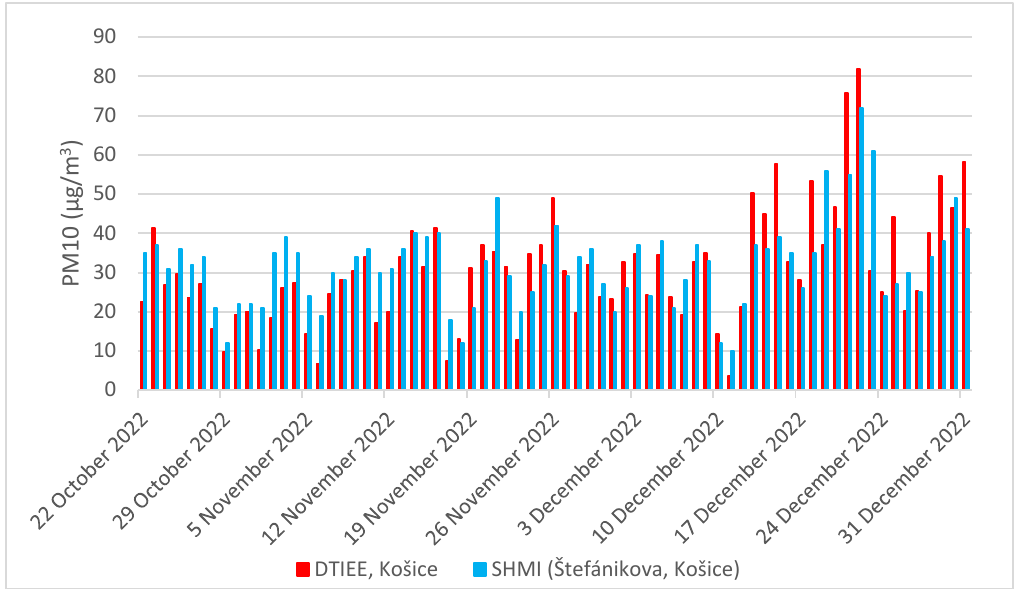
Figure 2. Daily averages of PM10 mass concentration at DTIEE (red bars) and Štefánikova, Košice (blue bars) measured from 22 October 2022 to 31 December 2022.